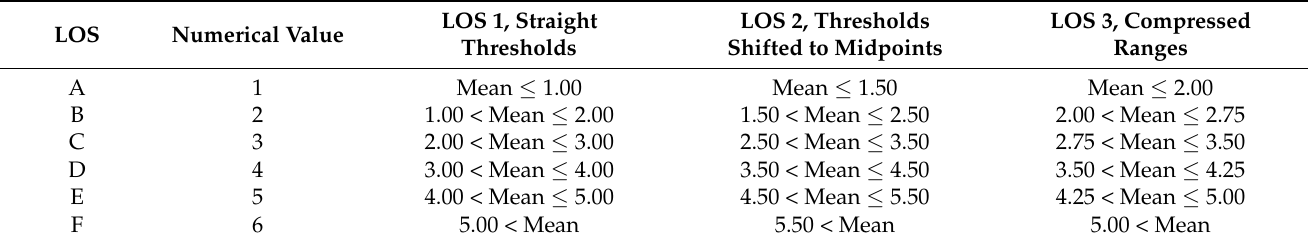
Table 5. Representation of Survey Results by a Single LOS Grade: LOS Mean Value Threshold Schemes.